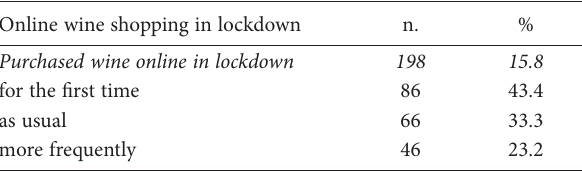
Table 4. Online wine shopping during the